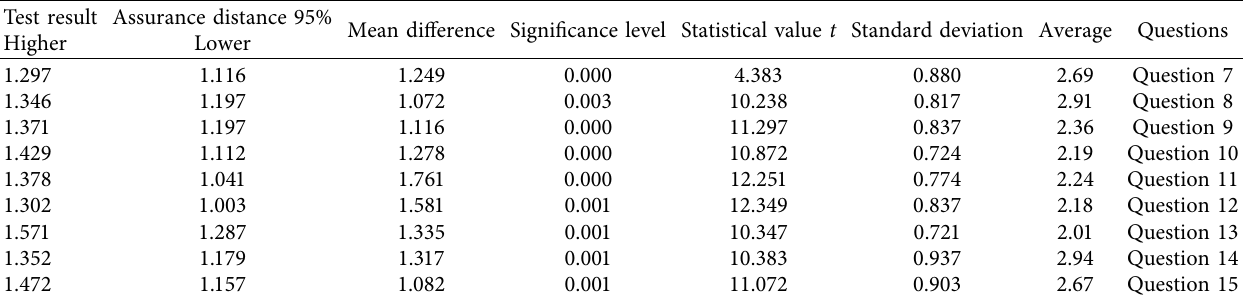
Table 3: Results of Student’s t test to investigate the impact of economic resilience index on natural disaster crisis